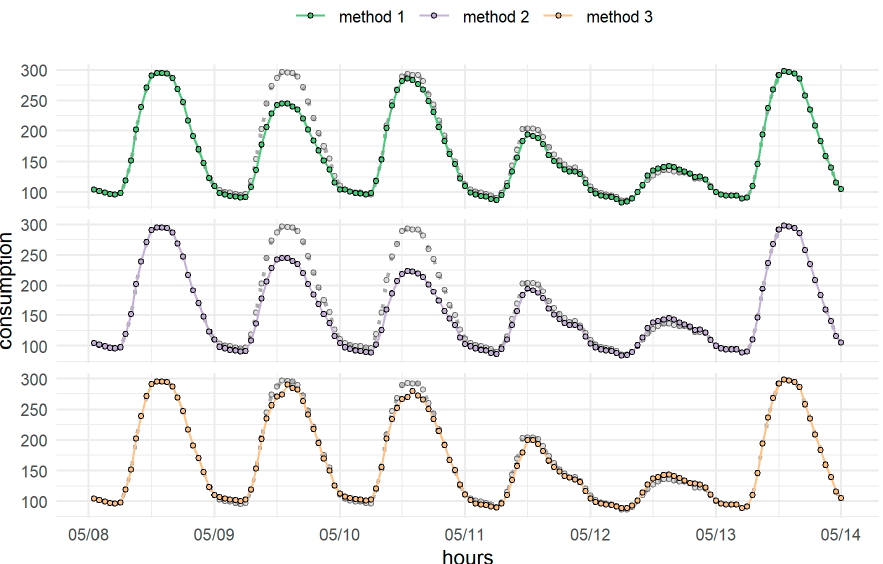
Figure 12. Actual consumption of PPE-Example4 and values after imputation according to the three imputation methods. Source: own elaboration.